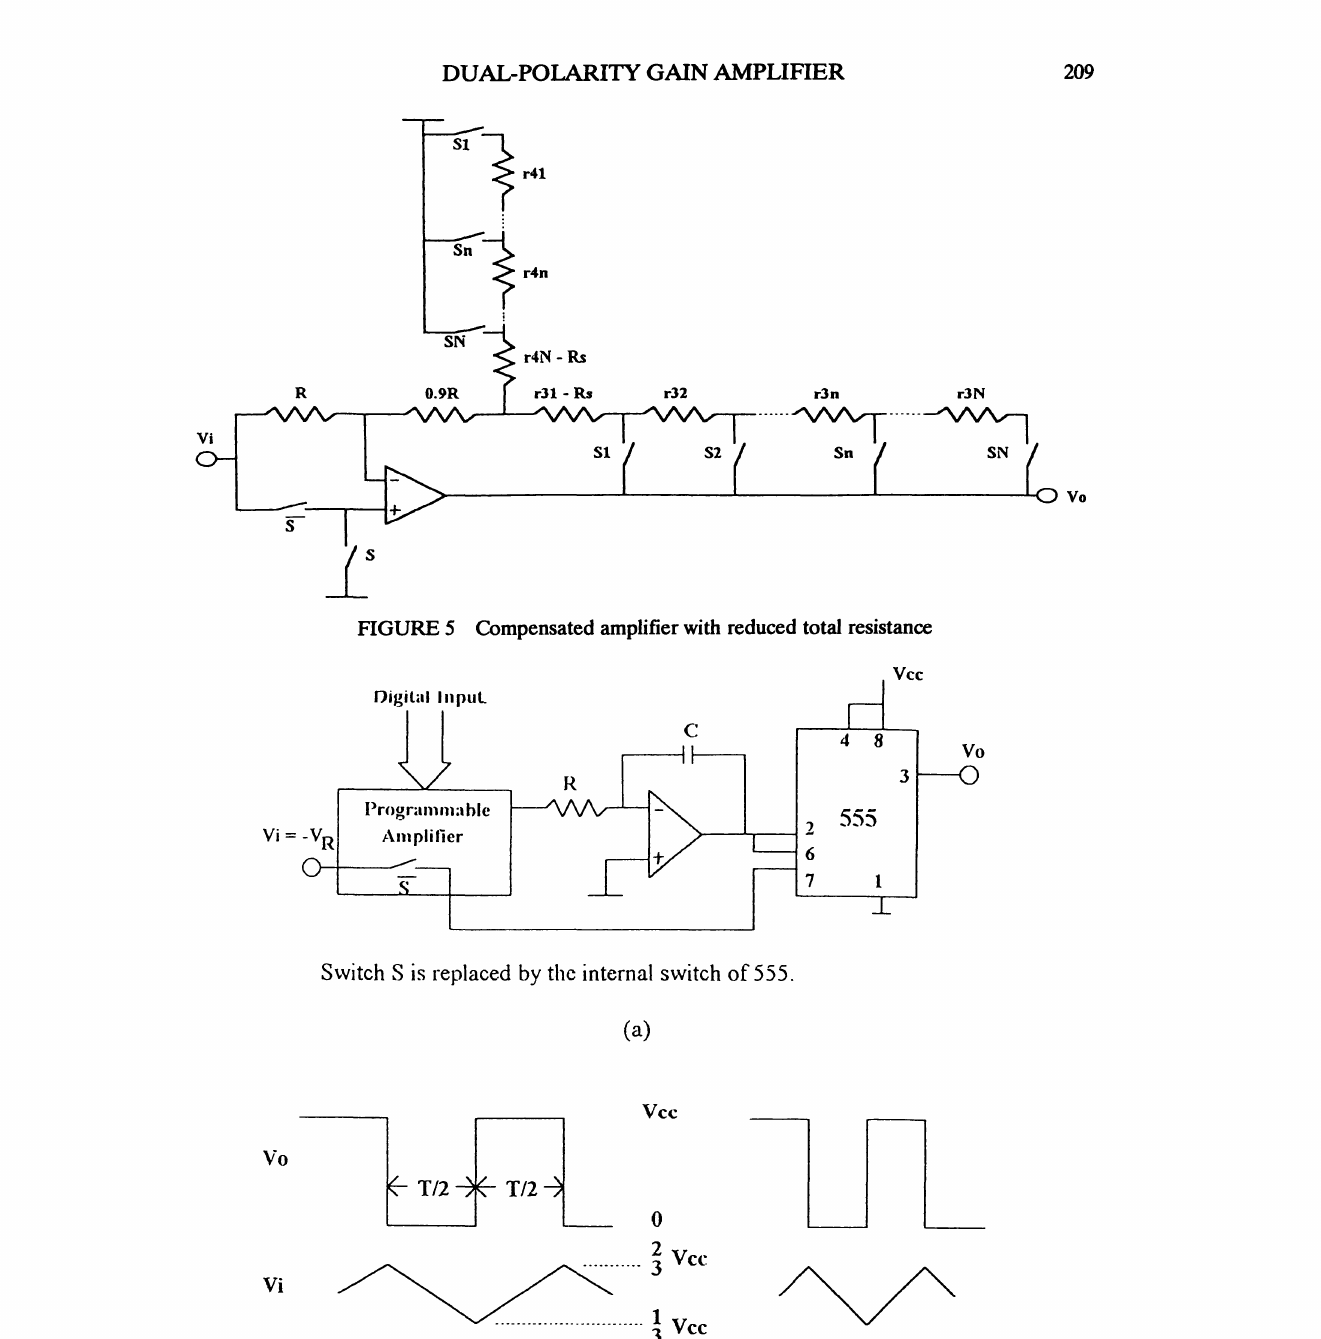
FIGURE 6 (a) Digitally programmable function generator (b) Waveforms for (i) Digital input (ii) Digital input D2, D > D